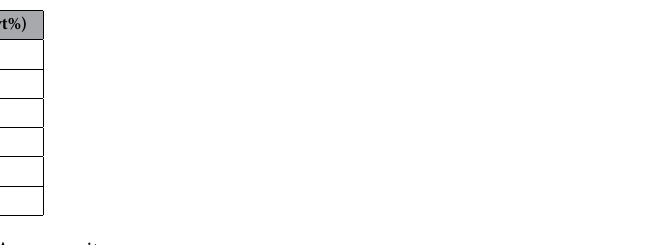
Table 1. Formulations of PLA/WS/HA